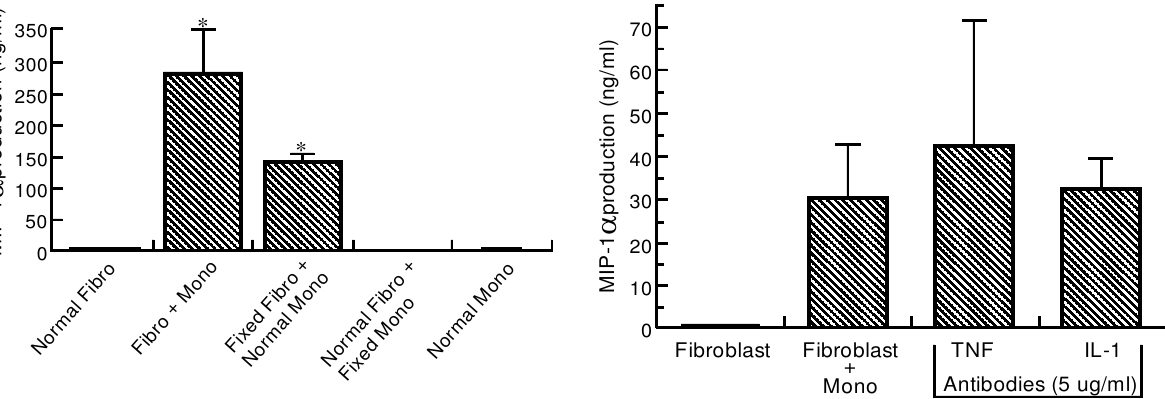
FIG. 3. MIP-1 a production is not affected by antibodies to either IL-1 or TNF. Antibodies were added to fibroblast– monocyte co-culture at time 0 at a concentration of 5 m g/ml. After 24h of co-culture the culture supernatant was har- vested and MIP-1 a was measured using a specific ELISA. Data represents mean ± SE of two repeat experiments. No significant decrease in MIP-1 a was observed. * P <0.05